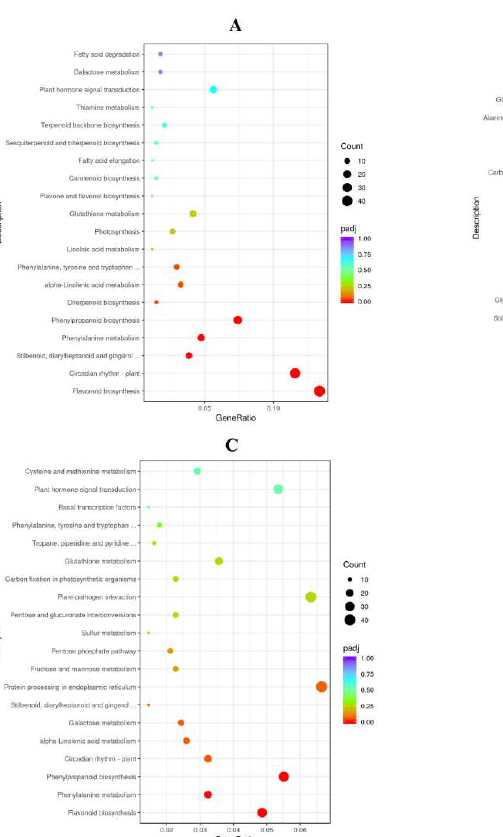
Figure 8. Go enrichment analysis of differentially expressed genes at 78 DAB (( A ): E vs. G, ( B ): F vs. G, ( C ): H vs. G).